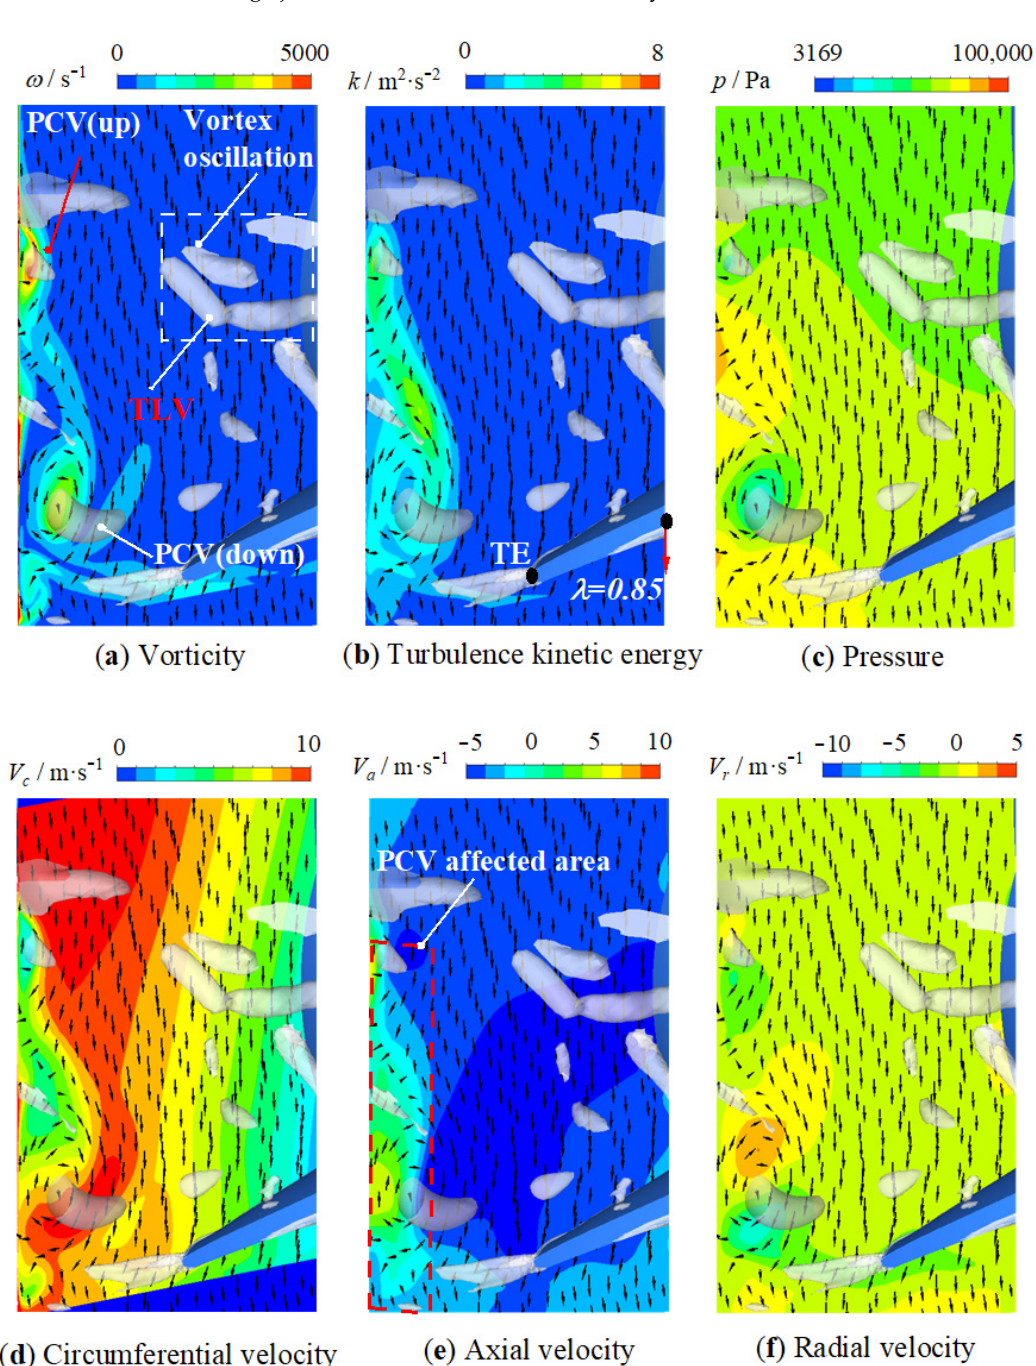
Figure 17. Distribution of plane physical quantities in the stage of vortex dissipative collapse at t = t 0 + 7T/30 (swirling strength isosurface Sw = 1000 s − 1 (white), Q = 0.8 Q BEP , σ = 0.35).